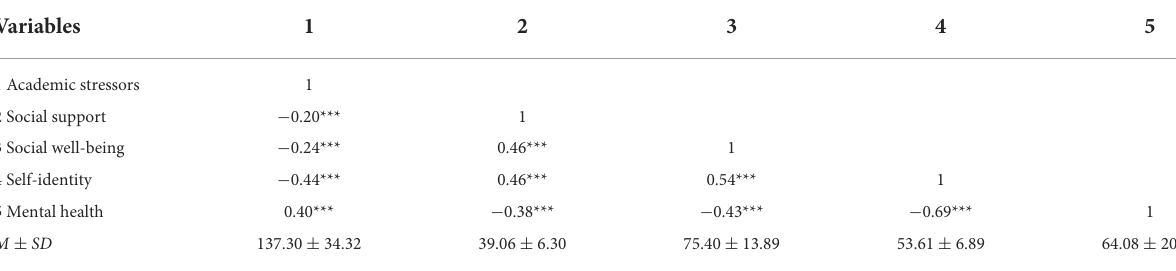
TABLE 2 Correlation analysis results of all